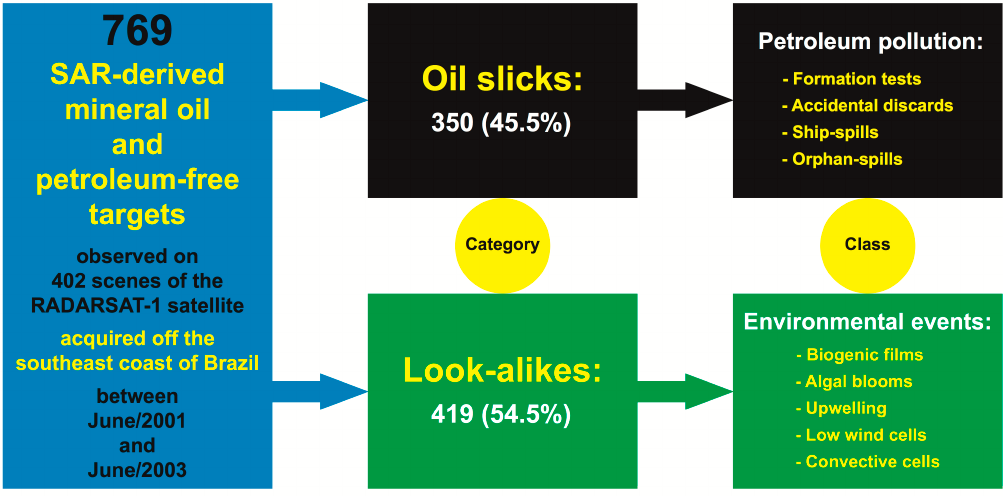
Figure 2. Sampling characteristics of the database that contains information from regions with low Synthetic Aperture Radar (SAR) backscatter observed on the surface of the ocean [17]. The available SAR-derived targets are divided in two categories: mineral oil slicks and other environmental phenomena (non-petroleum signals)—the latter is frequently referred to as radar false targets or “slick-alikes”. The respective classes of each category are also shown.